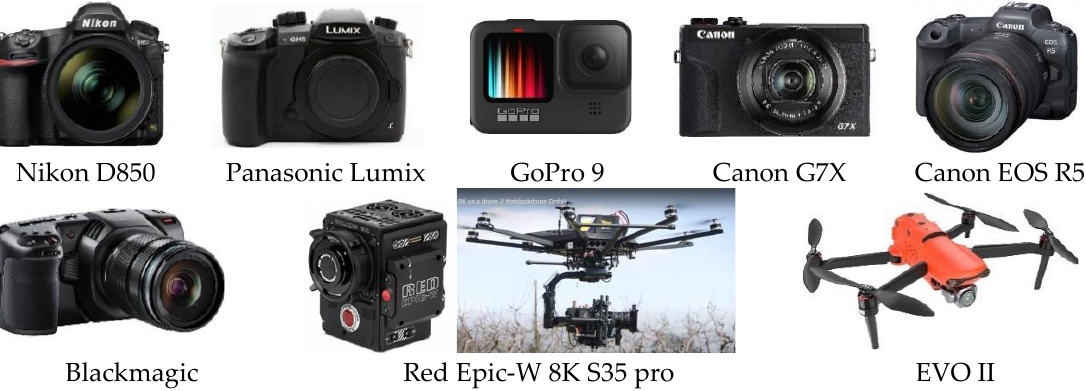
Figure 1. Different camera types are capable of taking UHD videos and the EVO II drone capable of taking 8K videos. Noticeably, the UHD video imaging resolutions (e.g., 4K, 6K, and 8K) have several